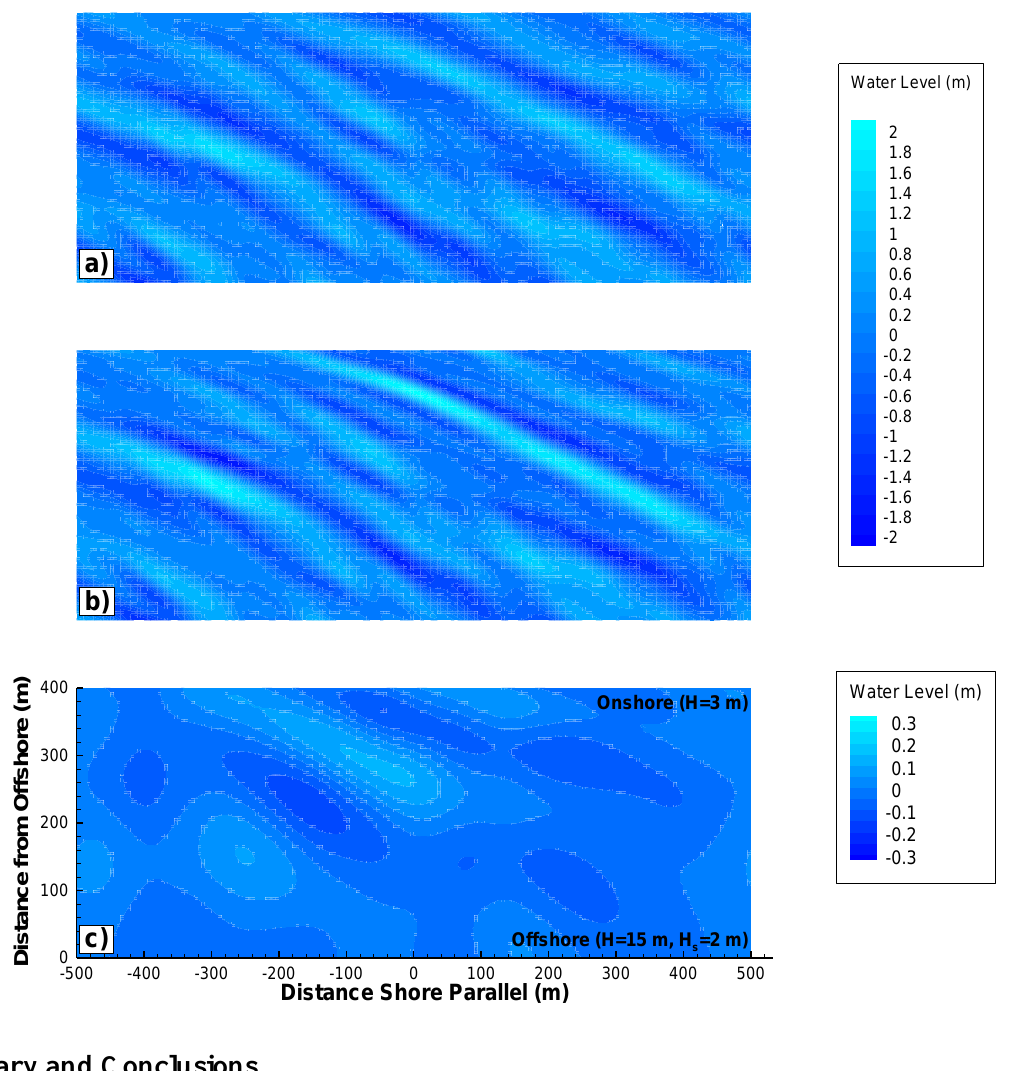
Figure 9. Contours of the simulated free surface elevation field for oblique propagation, corresponding to the spectrum shown in Figure 7 at a fixed (arbitrary) time. The parameters of the offshore spectrum are given in Table 1. ( a ) Linear model; ( b ) Nonlinear model; ( c ) Infragravity waves ( f < 0.05 Hz) generated during nonlinear